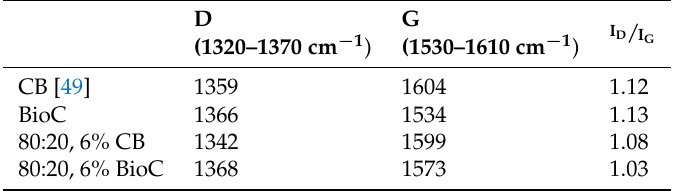
Table 6. Graphitic (G) and disordered (D) bands and peak intensity ratio ( I D / I nanofilled